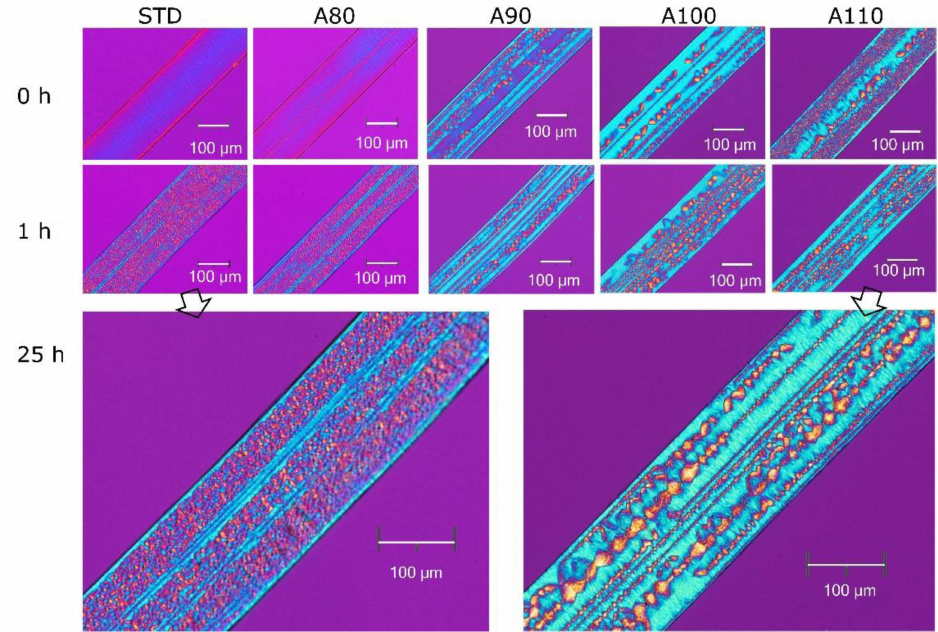
Figure 4. Changes in crystal morphology observed with POM during hydrolysis at 70 ◦ C and 95% RH for PLA annealed at various